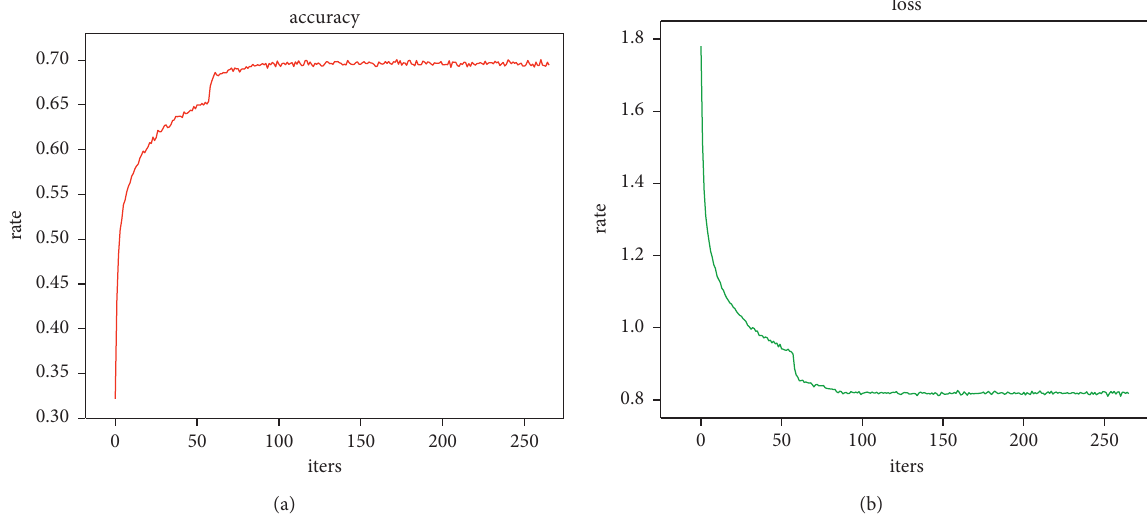
Figure 14: (a) Accuracy of CNN +LSTM under multimodal fusion database and (b) loss function of the training model.